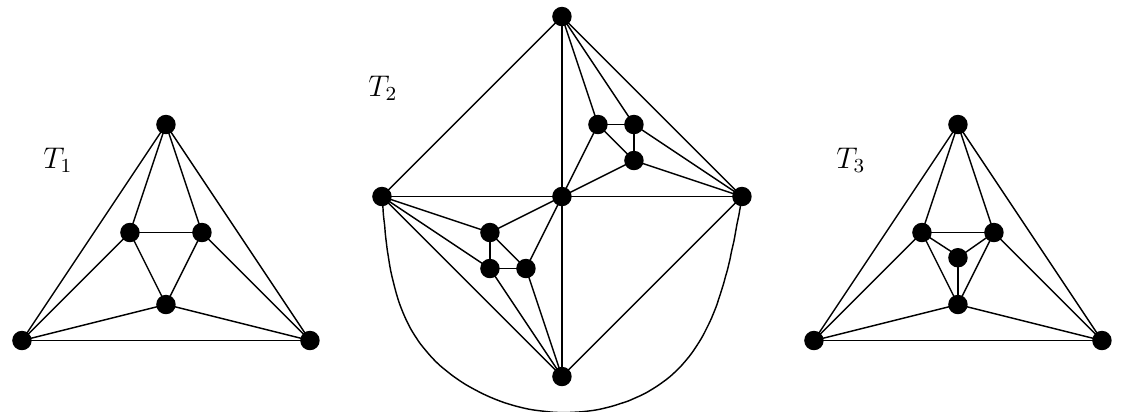
Figure 5: Planar triangulations T γ ( T ) = 3 > γ ( T 2 3